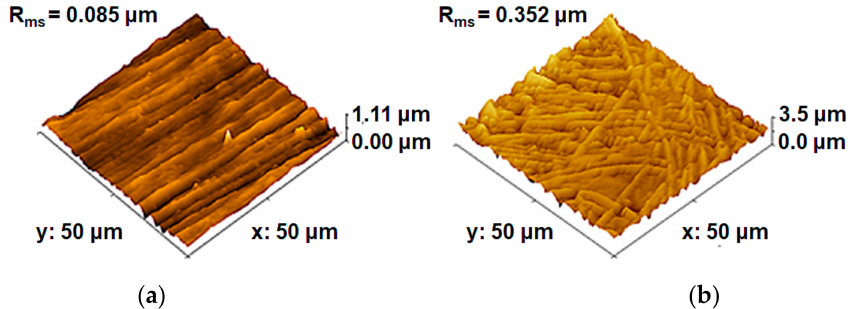
Figure 2. Atomic force microscopic (AFM) images of flat TiZr ( a ) and nanochannelar TiZr surfaces ( b